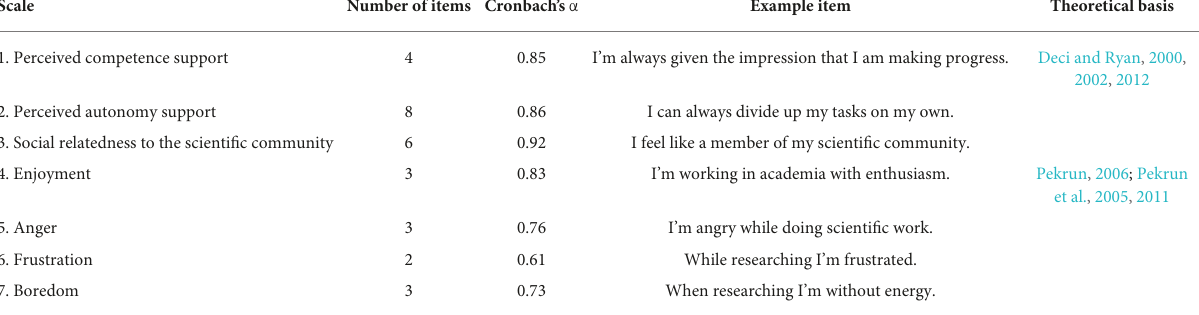
TABLE A1 Overview about the seven different scales of the present study.